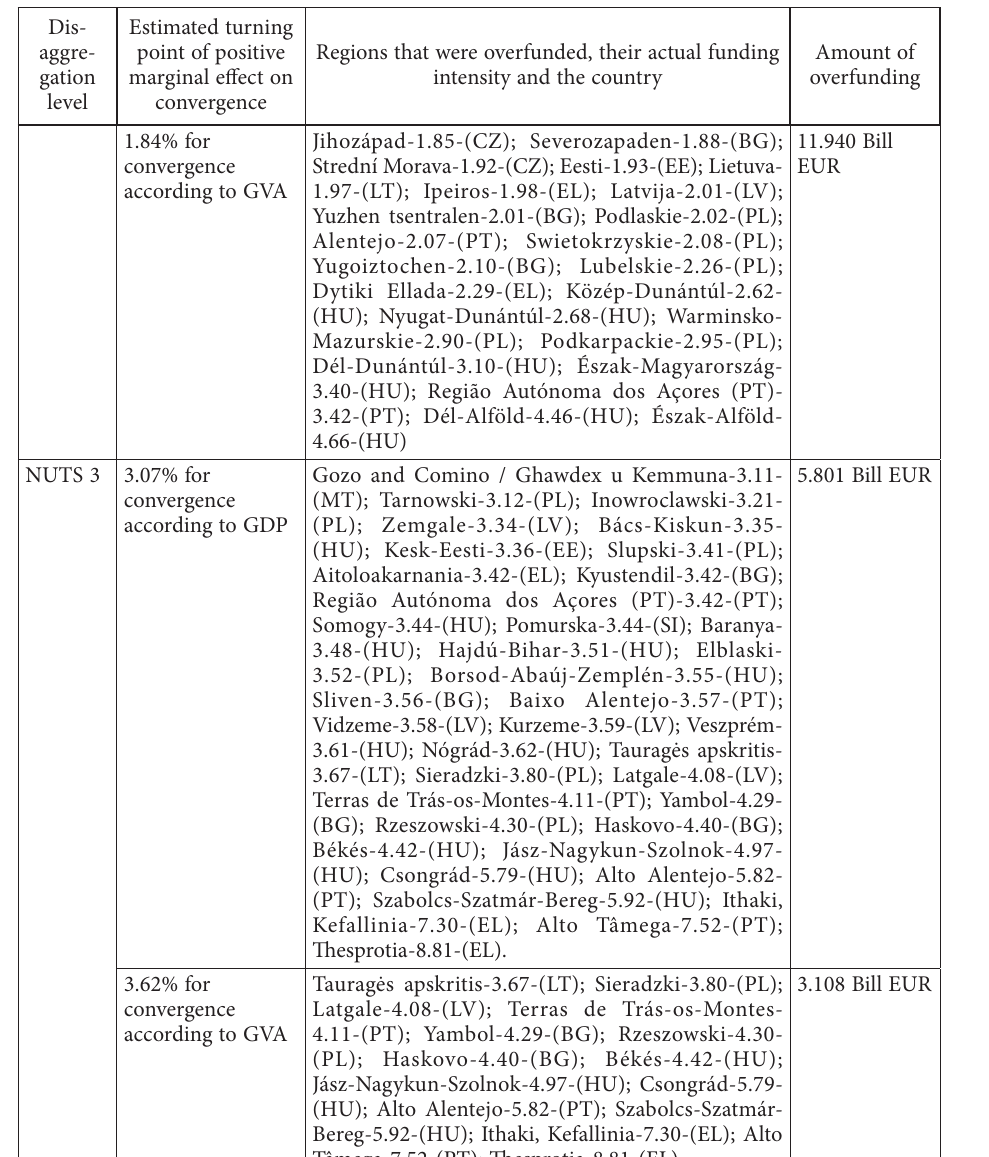
11.940 Bill EUR